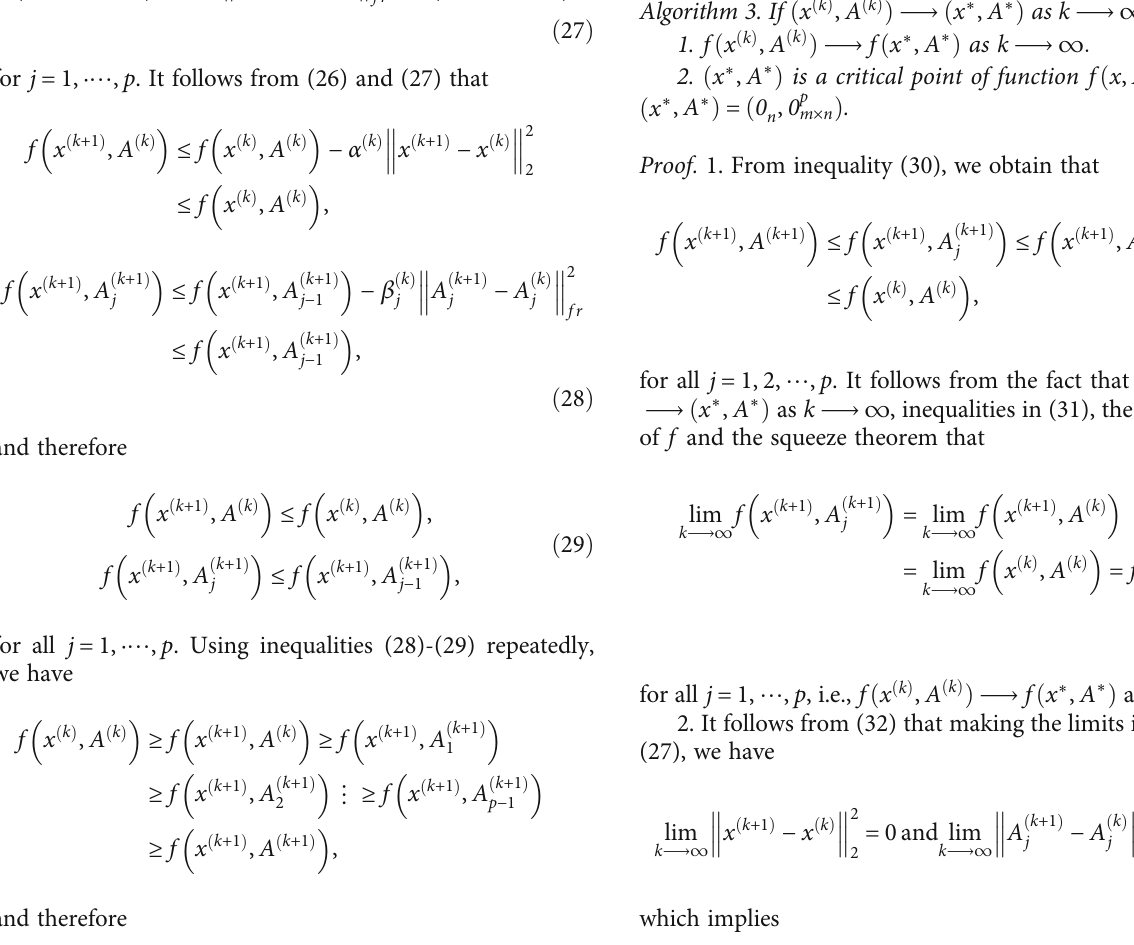
Algorithm 3. If ð x ð k Þ , A ð k Þ Þ ⟶ ð x ∗ , A ∗ Þ as k ⟶ ∞ , then.